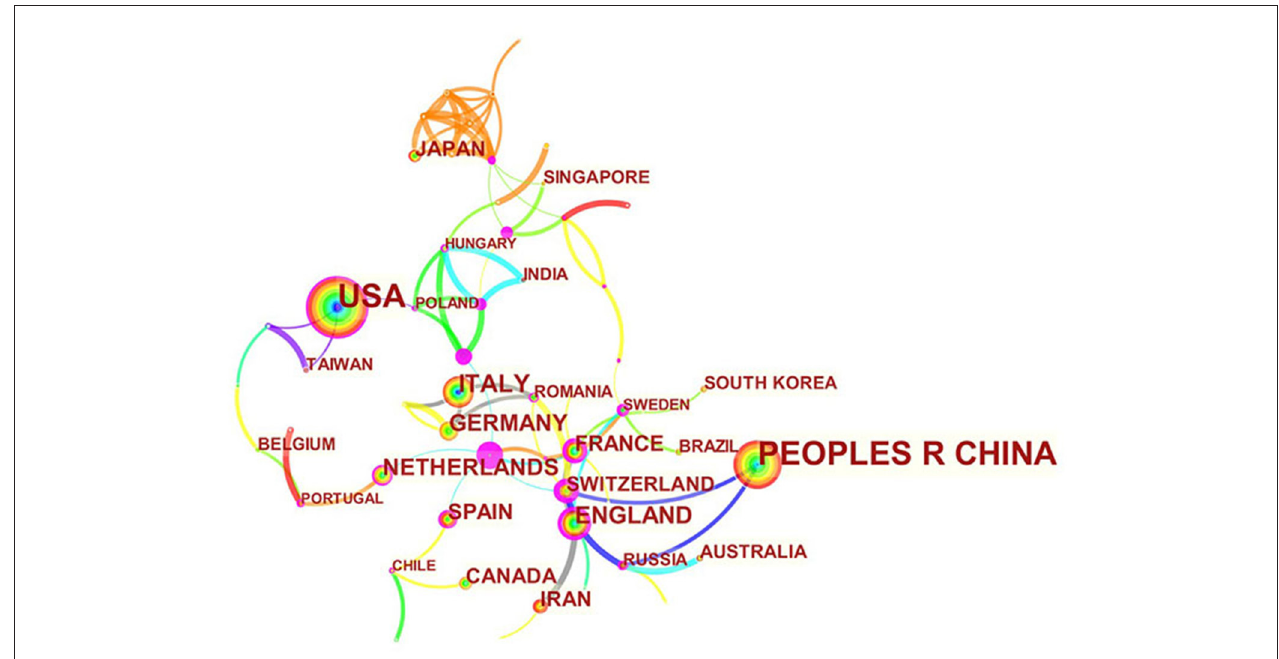
FIGURE 3 | Distribution of publications from different countries.